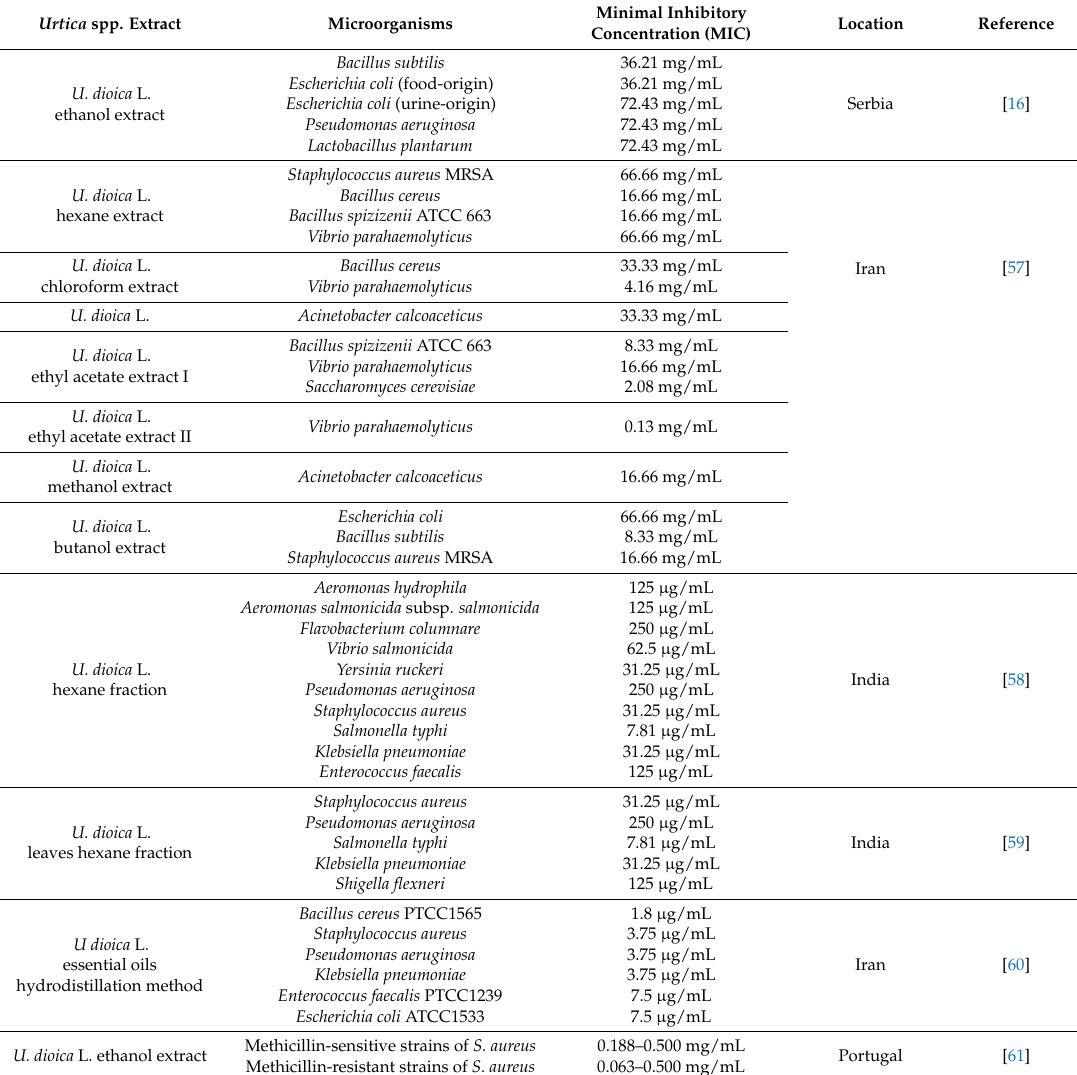
Table 5. In vitro activity of Urtica spp. against microorganisms: minimal inhibitory concentrations. Urtica spp.